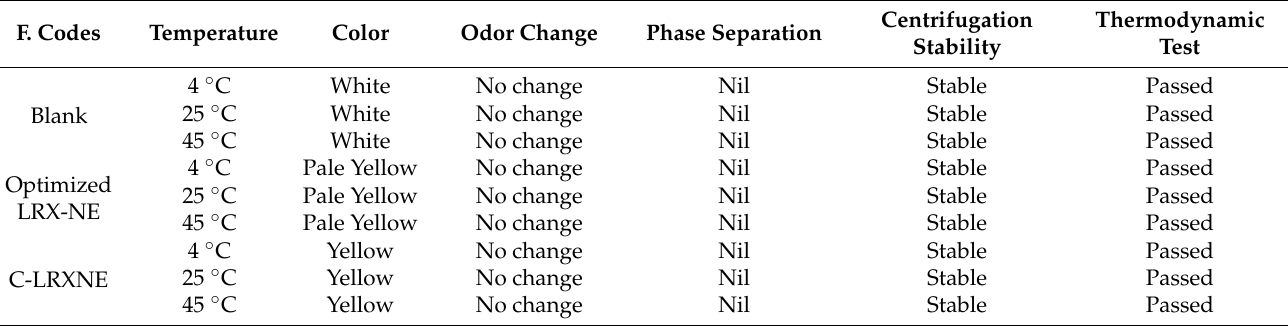
Table 3. Physical characterization of optimized Blank, LRX-NE (LRX-6), and C-LRX NE formulations at various